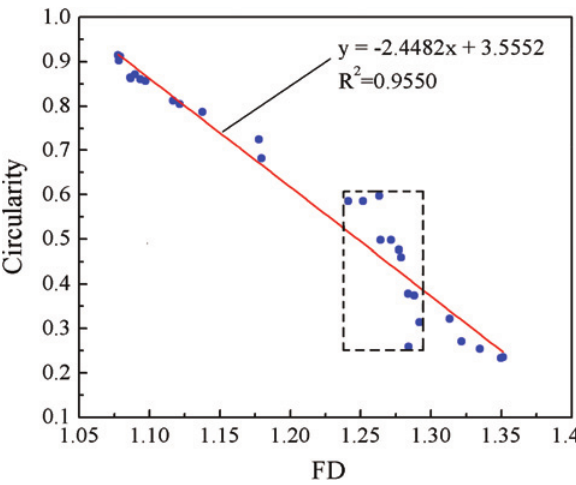
Figure 4: Relationship between the FD and the circularity of the